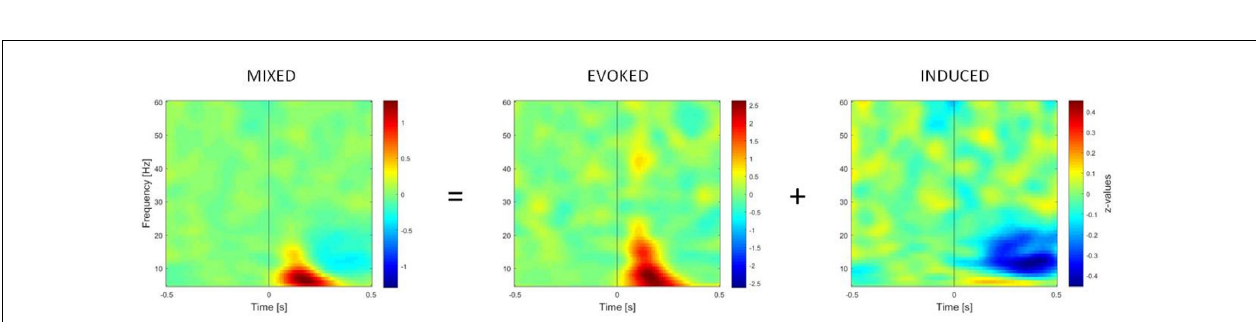
FIGURE 2 | Time-frequency representations (TFRs) of mixed, evoked (phase-locked) and induced (non-phase-locked) activity, calculated over 11 right occipito-temporal electrodes (region of interest determined by the literature on the face inversion effect), averaged over 23 participants. Activity elicited by upright faces is shown. The picture shows how the induced activity is determined by computing the TFR of evoked activity (on ERPs averaged across trials) and subtracting it from the mixed activity at the single-trial level.